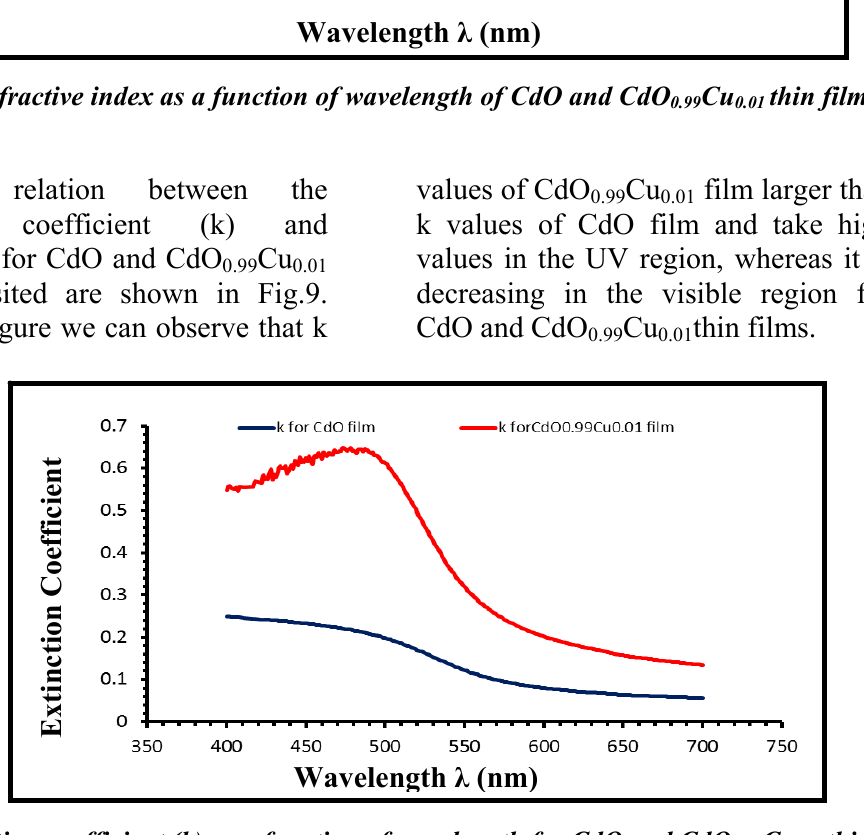
Cu thin films. 0.99 0.01